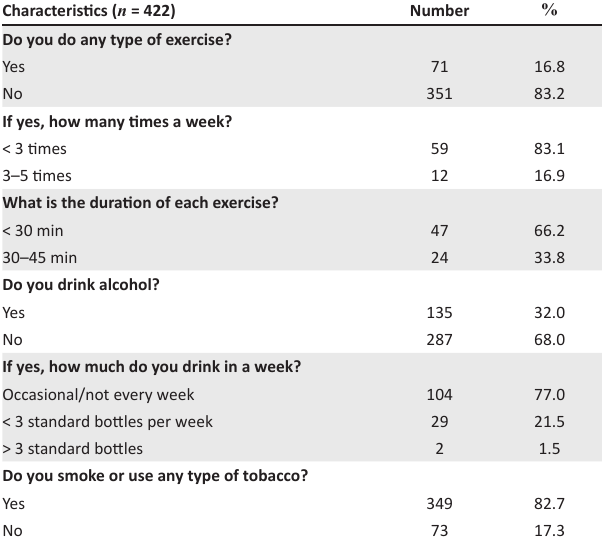
TABLE 3: Characteristics of lifestyle choices.